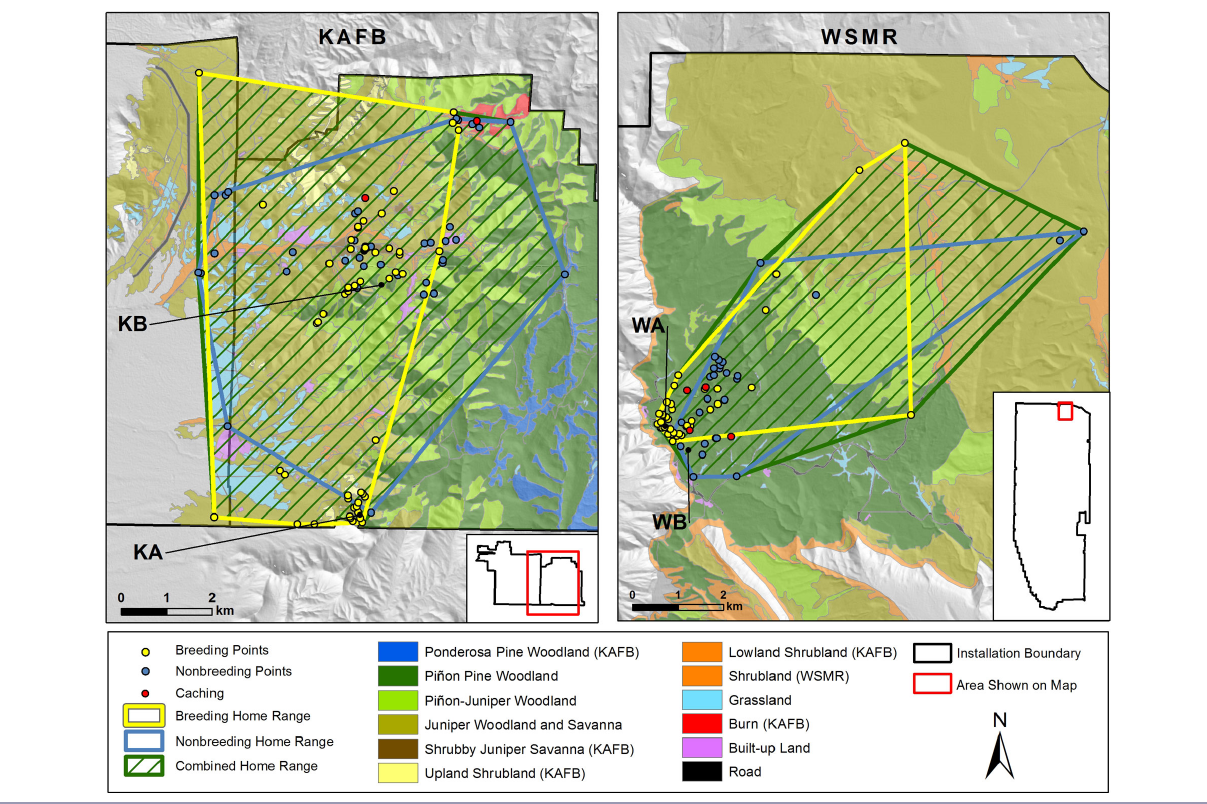
Fig. 3 . Pinyon Jay ( Gymnorhinus cyanocephalus ) breeding season, nonbreeding season, and year-round observations and home ranges at Kirtland Air Force Base (KAFB) and White Sands Missile Range (WSMR). Home ranges created by minimum bounding geometry (minimum convex) polygons. Background shows land cover